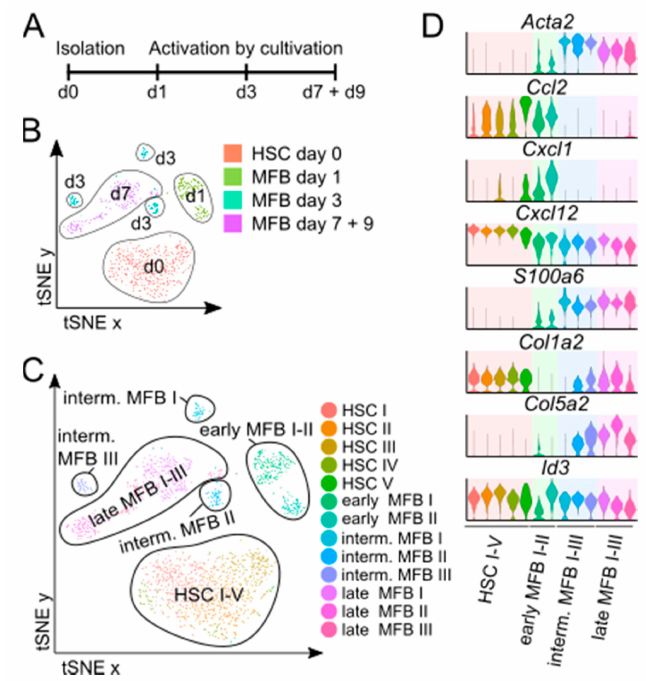
Figure 4. Single-cell RNA sequencing analysis of in vitro activated myofibroblasts. ( A ) Schematic overview of the experimental setup. ( B ) t-SNE plot showing all in vitro activated MFB and resting HSCs dependent on their origin. ( C ) t-SNE plot showing all in vitro activated MFB and resting HSCs dependent on cluster. ( D ) Violin plots showing the relative expression of selected marker genes for each cluster. n = 4 with an average of 1000 cells per